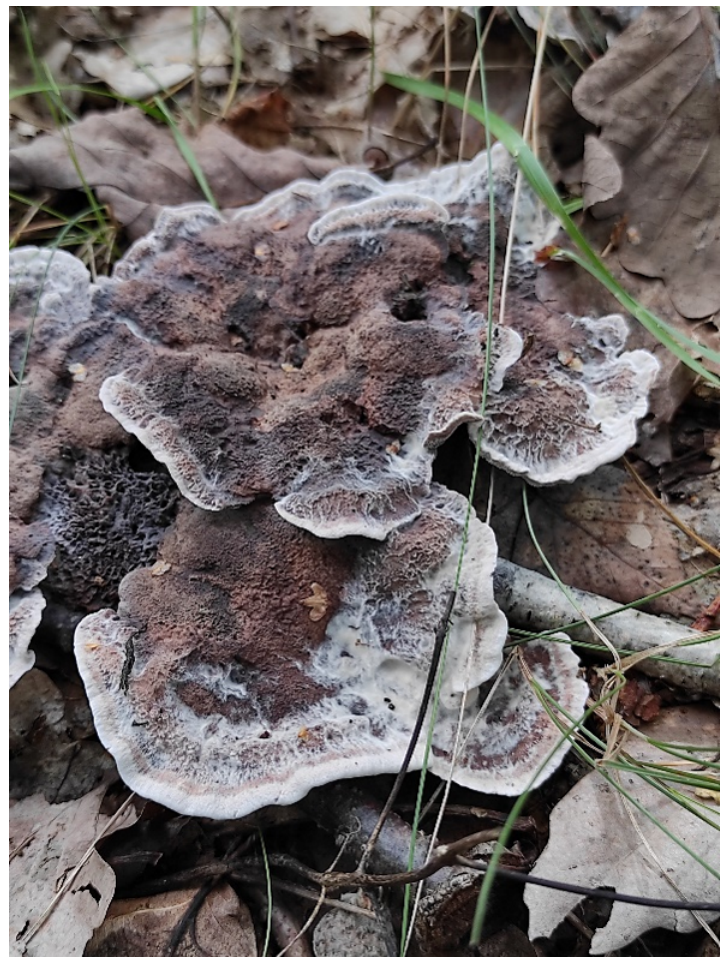
Figure 6 Basidiomata of Phellodon confluens from Kampinos National Park; September 4, 2021. Photography by A.